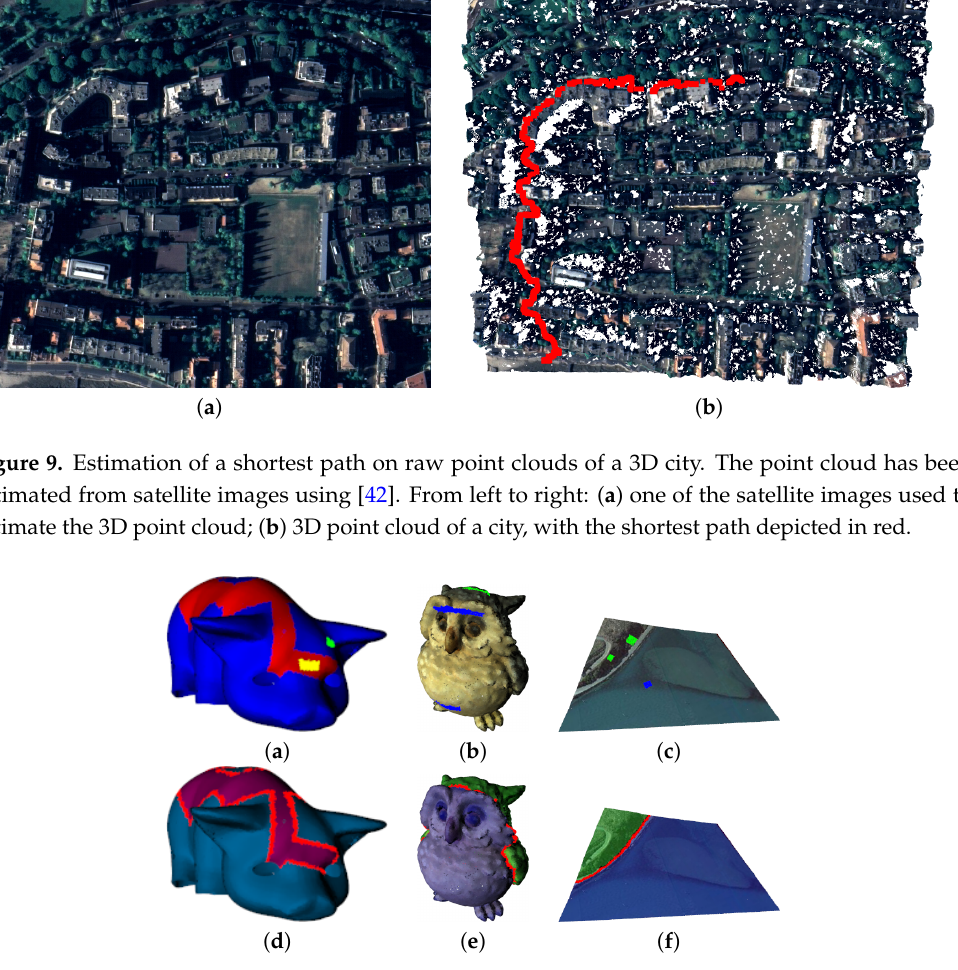
Figure 10. Segmentation of 3D point clouds based on the colorimetric values by solving the Eikonal equation with P ( u ) = 1 (see Section 4.2.1). ( a – c ) contain initial labels on point clouds. ( d – f ) show the results of the colorimetric segmentation, where red color represents the border between the blue and the green